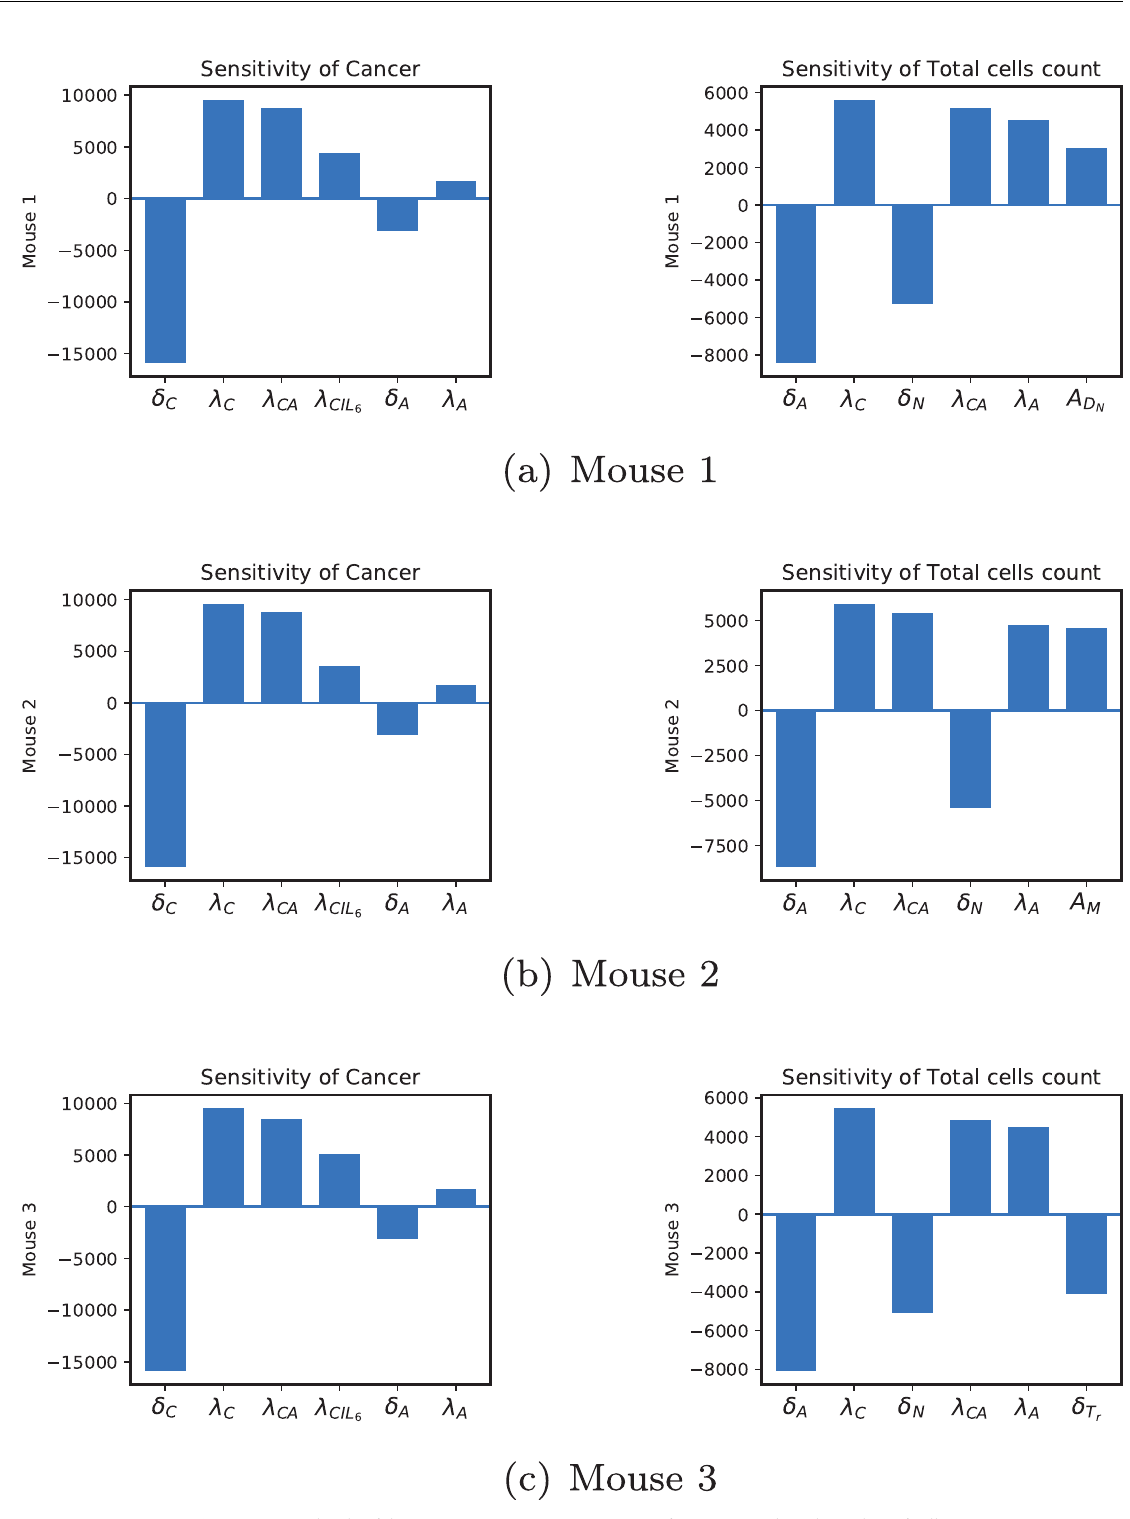
Fig 4. Sensitivity results. Sensitivity levels of the top 6 most sensitive parameters for cancer and total number of cells.